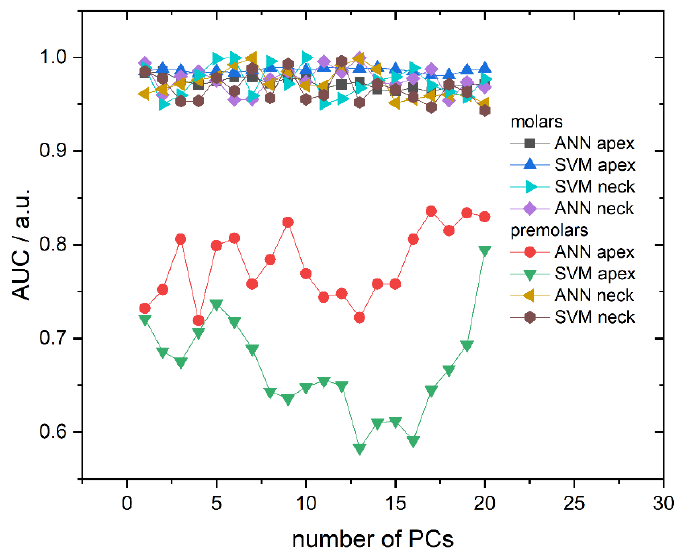
Figure 5. Area Under the ROC Curve (AUC) in dependence on the number of used PCs for all calculated models. Lines between symbols were added as a visual aid.